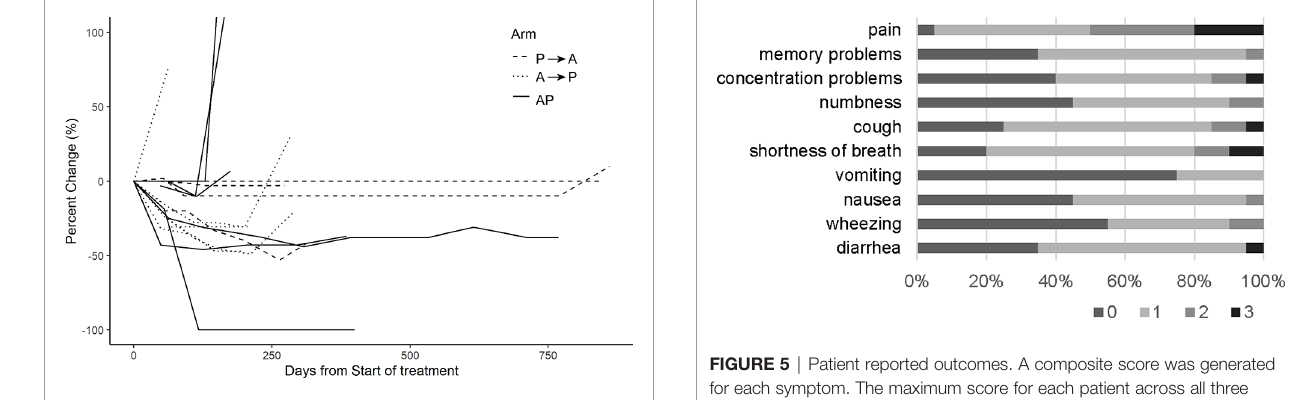
FIGURE 3 | Investigator assessed change in target lesions over time (*cutoff